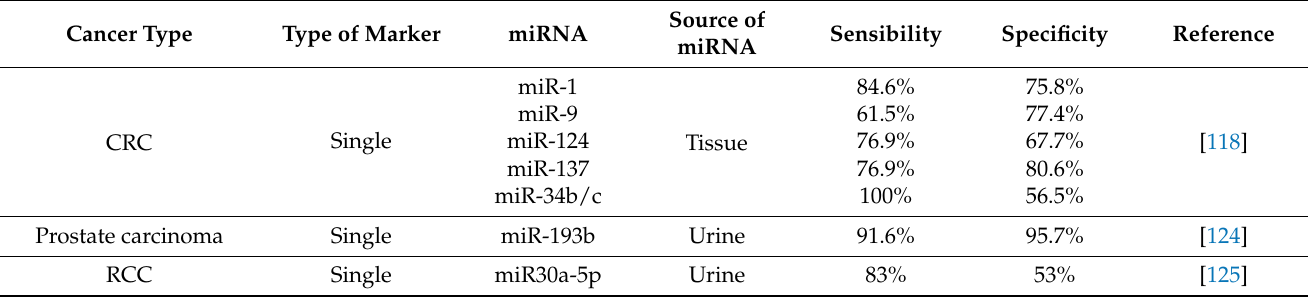
Table 2. miRNAs methylation as a biomarker for cancer